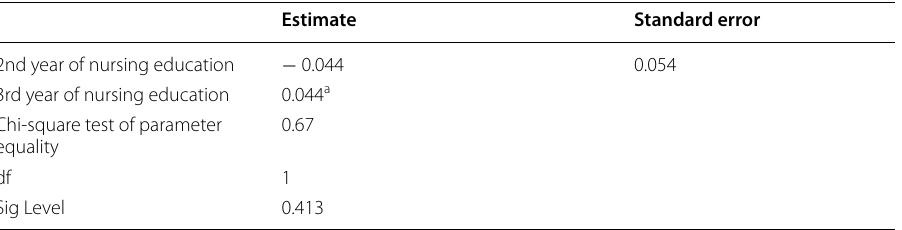
Table 12 Global DIF analysis to identify subgroup invariance between years of nursing education for measurement in the second